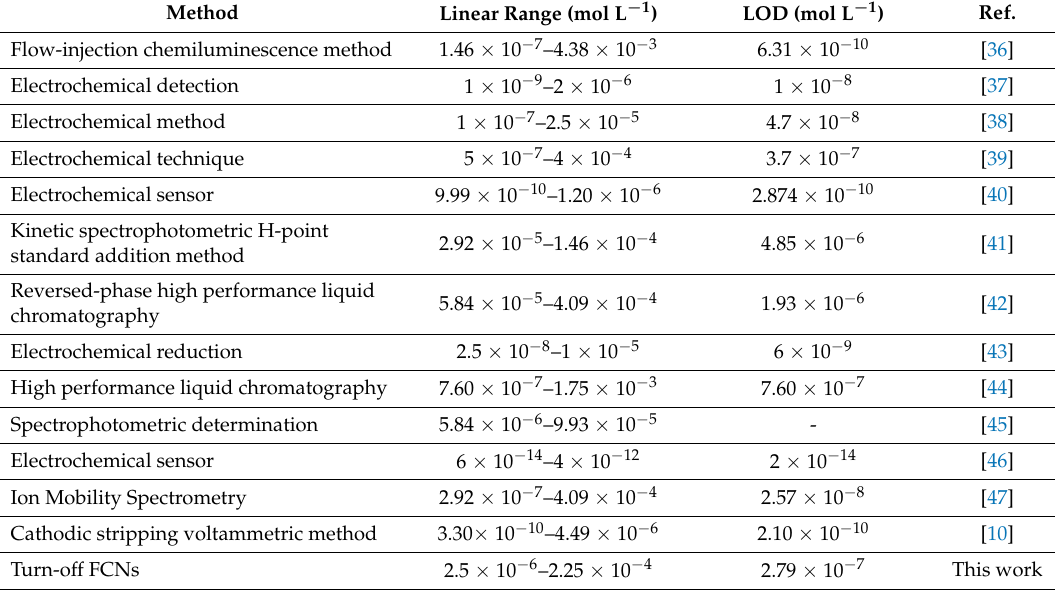
Table 4. Comparison of the proposed method with other methods for the determination of metronidazole.